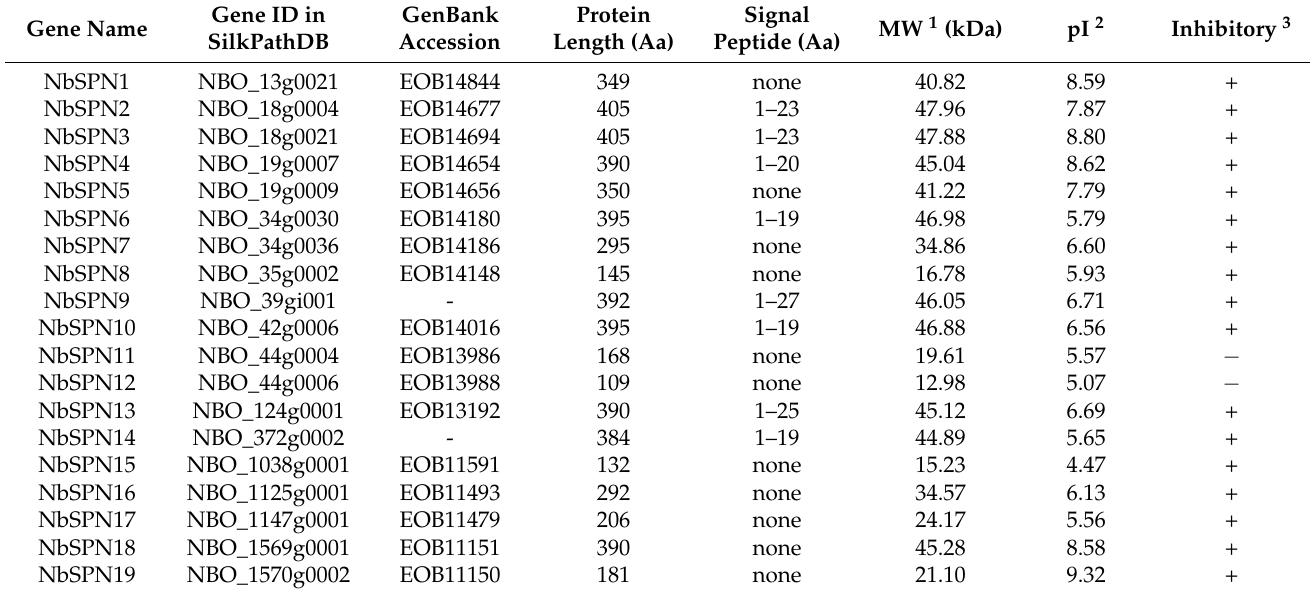
Table 1. Basic information of serpins in N. bombycis . 1 MW, molecular weight; 2 pI, isoelectric point; 3 Inhibitory, Prediction of inhibitory serpin by RCL hinge region length and sequence consensus mode, “+” represents inhibitory serpin; “ − ” represents non-inhibitory serpin. Signal peptide was predicted with SignalP-5.0 online: https://services.healthtech.dtu.dk/service.php?SignalP-5.0, accessed on